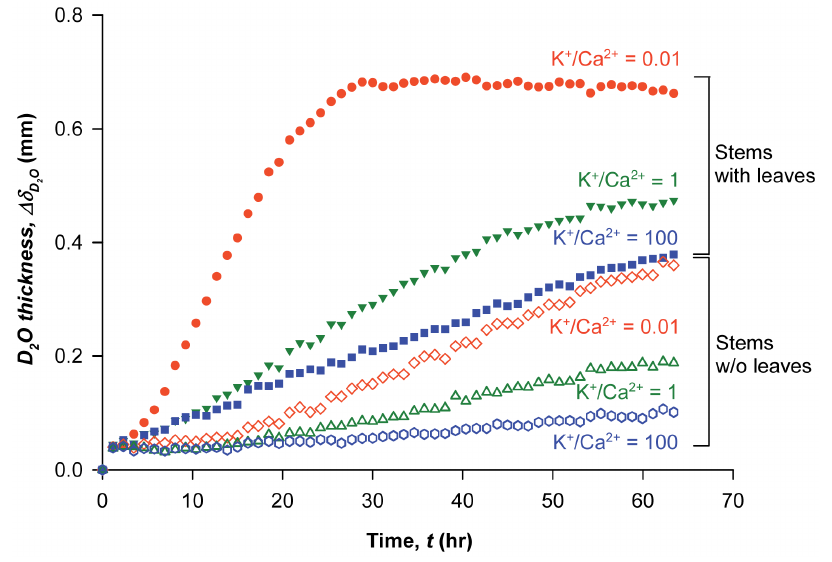
Figure 3. Physicochemical process of ion-mediated sap flow regulation. Effect of K + /Ca 2 + ratios on the variations of ionic D 2 O thickness in the laurel stems with and without leaves for 64 h. Temporal variations in ionic D 2 O contents in the region of interest for the excised laurel stems with leaves (closed symbol) and without leaves (open symbols) were measured using neutron imaging technique for 64 h. Closed orange circles and open orange diamonds denote K + /Ca 2 + =0.01; closed green rotated triangles and open green triangles denote K + /Ca 2 + =1; and closed purple rectangles and open purple hexagons denote K + /Ca 2 + =100. doi:10.1371/journal.pone.0098484.g003 no change (dark blue). Therefore, the increase in X-ray absorption (and thus the color shift from dark blue) illustrated an increase in ionic solution with iopamidol. Synchrotron X-ray images show local inhomogeneity in the X-ray absorption, as shown in square boxes of Fig. 1A, which represent the ROI in xylem conduits rapidly filling with newly introduced ionic solutions. In the ROI, different xylem conduits pulled-up the ionic solutions at varying speeds.